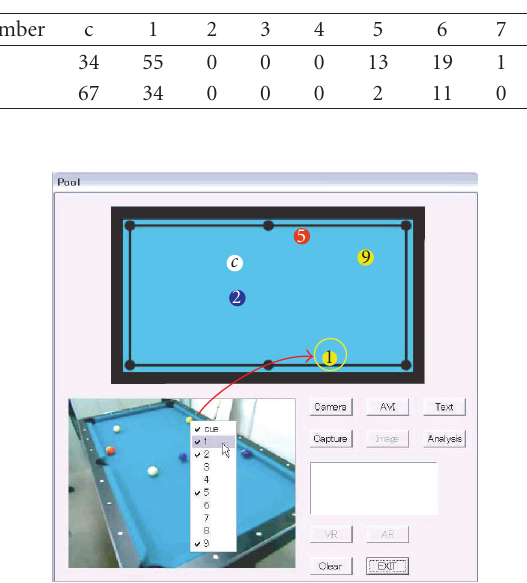
numbers of white cue ball and balls from number 1 to number 9 as shown in Figure 7(a).